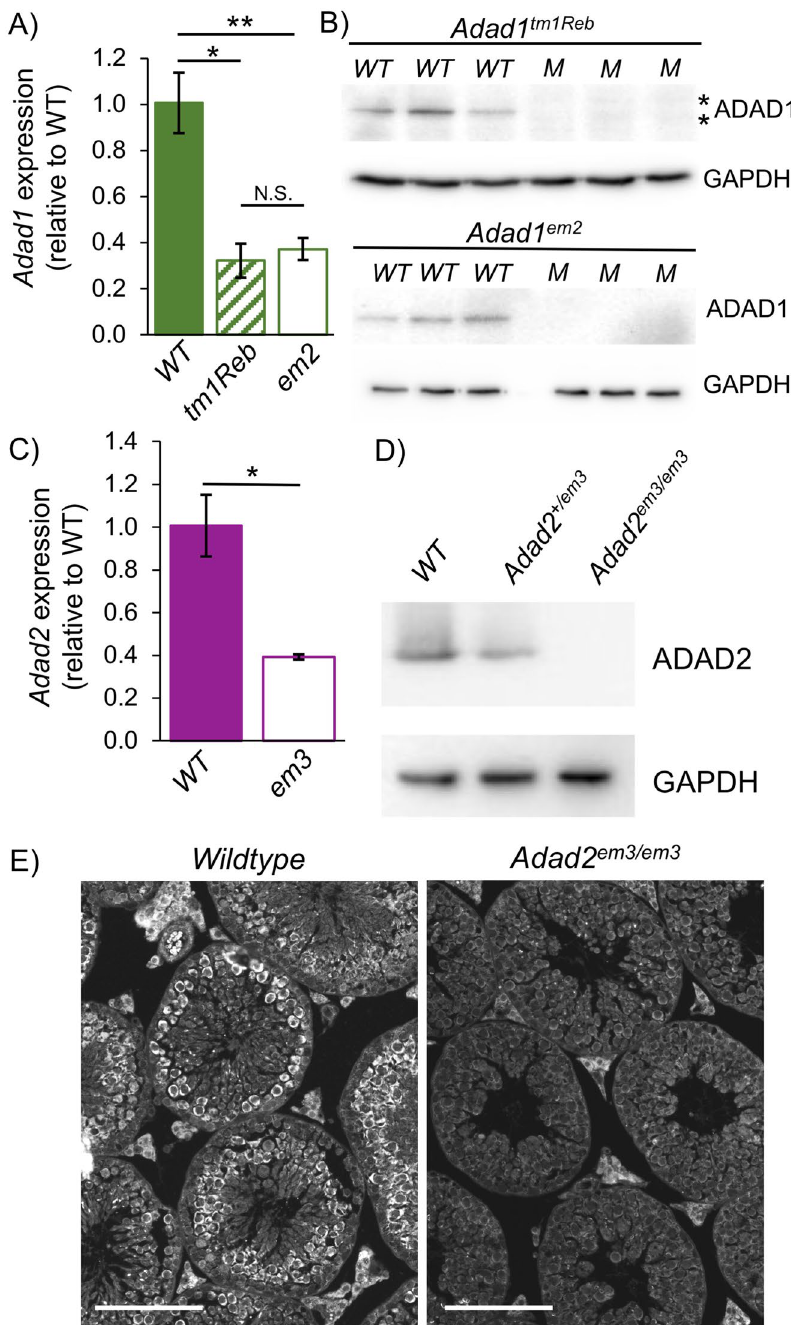
Figure 2. CRISPR-induced mutation results in molecular ablation of Adad1 and Adad2. ( A ) Adad1 expression in adult testes of wildtype (WT) and homozygous Adad1 mutants assessed by qRT-PCR. N ≥ 3, error bars— standard deviation. ( B ) Western blot detection of ADAD1 (~ 70 kDa) in adult wildtype (WT) and Adad1 mutant (M) testes. GAPDH (34 kDa) shown as a loading control. Allele of interest indicated above blot. Each lane represents an independent biological replicate. Asterisks indicate additional bands specific to the tm1Reb allele recognized by the ADAD1 antibody. ( C ) Adad2 expression in wildtype (WT) and Adad2 em3/em3 adult testes assessed by qRT-PCR. N ≥ 3, error bars—standard deviation. ( D ) Western blot detection of ADAD2 (~ 70 kDa) in adult Adad2 wildtype (WT), heterozygous mutant, and homozygous mutant testes. GAPDH (34 kDa) shown as a loading control. E. ADAD2 immunofluorescence in wildtype and Adad2 mutant adult testis. Bar—100 um. * p-value < 0.01, ** p-value < 0.001, N.S.—not